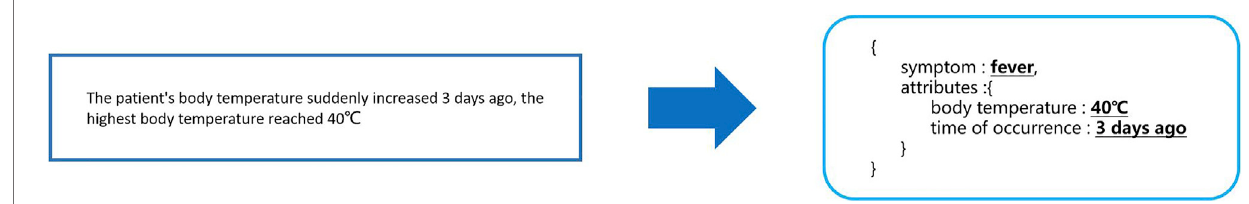
FIGURE 1 | Extract fever-related attributes from the fever description segment.